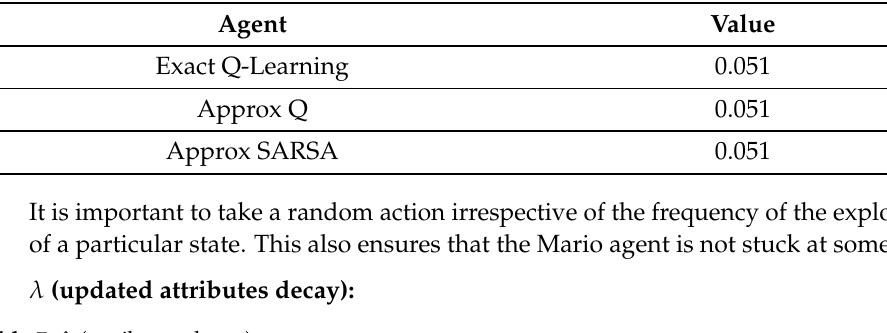
Table 7. λ (attributes